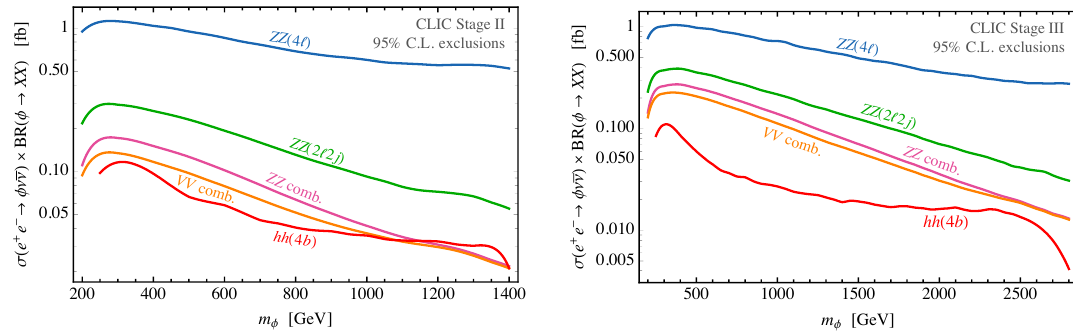
Figure 4. Comparison between the projected 95% C.L. exclusions in di(cid:11)erent channels on (cid:27) ( e + e (cid:0) ! (cid:30)(cid:23) (cid:22) (cid:23) ) (cid:2) BR( (cid:30) ! XX ), with X = h; Z . The limits, from top to bottom, come from (cid:30) ! ZZ ! 4 ‘ (blue), (cid:30) ! ZZ ! 2 ‘ 2 j (green), combination of (cid:30) ! ZZ ! 4 ‘; 2 ‘ 2 j; 4 j (pink), combination of (cid:30) ! ZZ and (cid:30) ! WW (orange, assuming BR (cid:30) ! WW = 2 BR (cid:30) ! ZZ ), and (cid:12)nally p p (cid:30) ! hh ! 4 b (red). Left: CLIC with s = 1 : 5 TeV, L = 1 : 5 ab (cid:0) 1 . Right: CLIC with s = 3 TeV, L = 3 ab (cid:0) 1